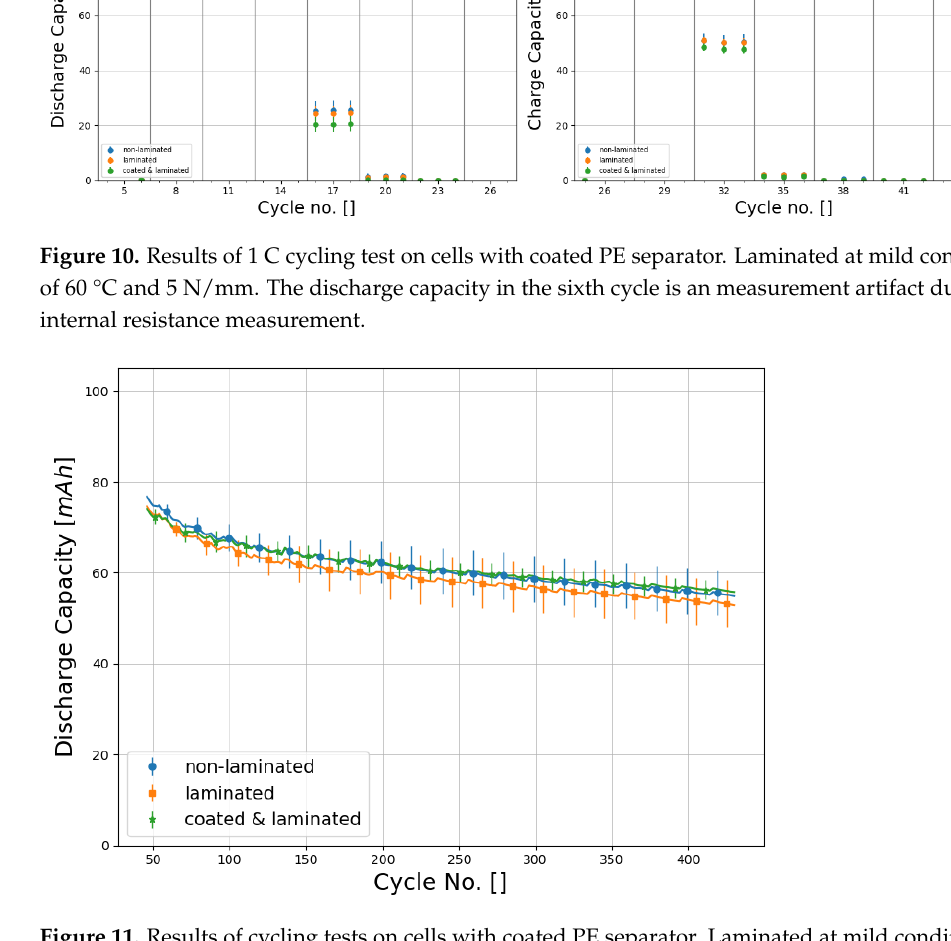
Figure 11. Results of cycling tests on cells with coated PE separator. Laminated at mild conditions of 60 °C and 5